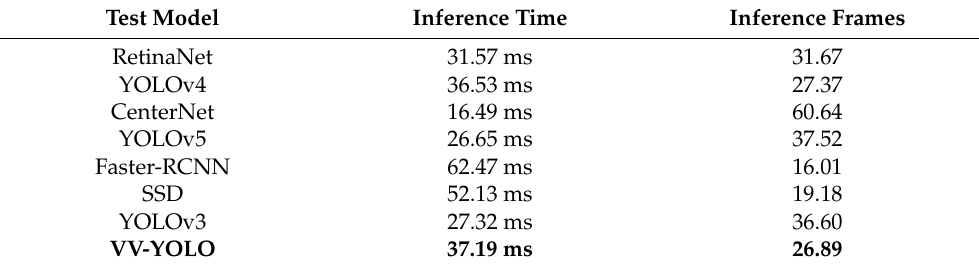
Table 5. Real-time comparison between the VV-YOLO model and the mainstream object detec- tion model.